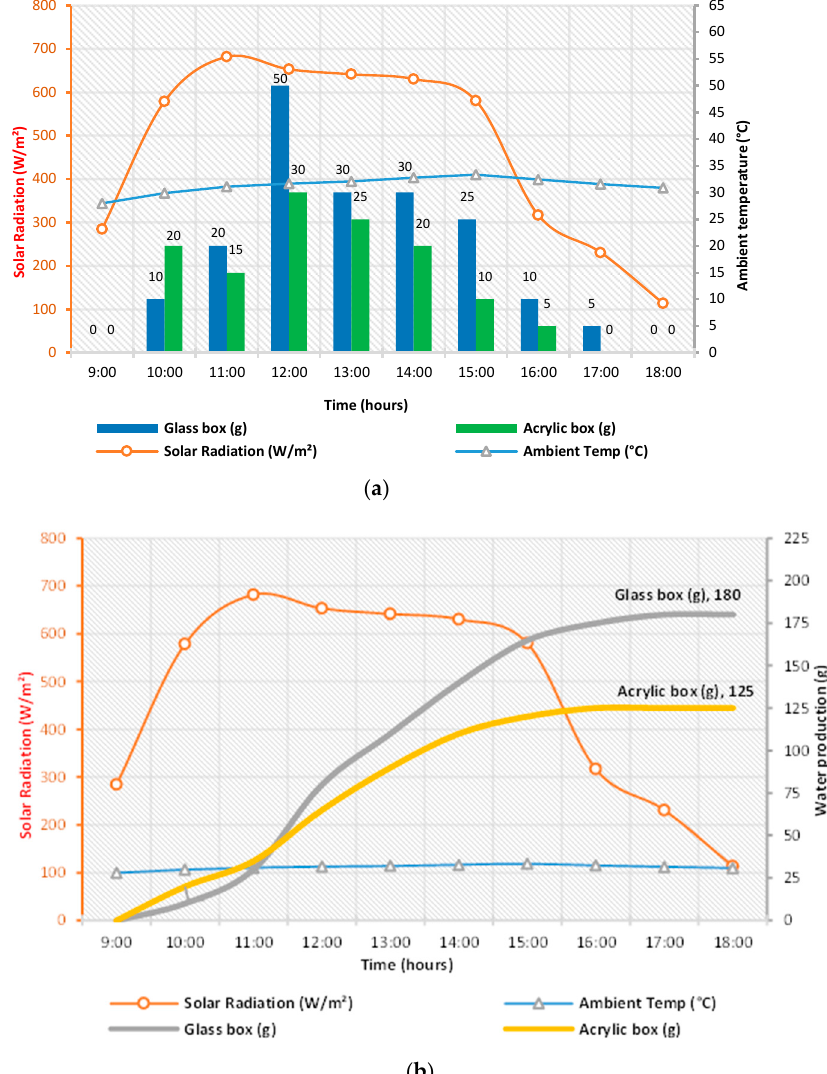
Figure 16. Variation of water production by glass and acrylic glazing systems on 1 August 2020: ( a ) hourly water produced and ( b ) accumulated water produced.